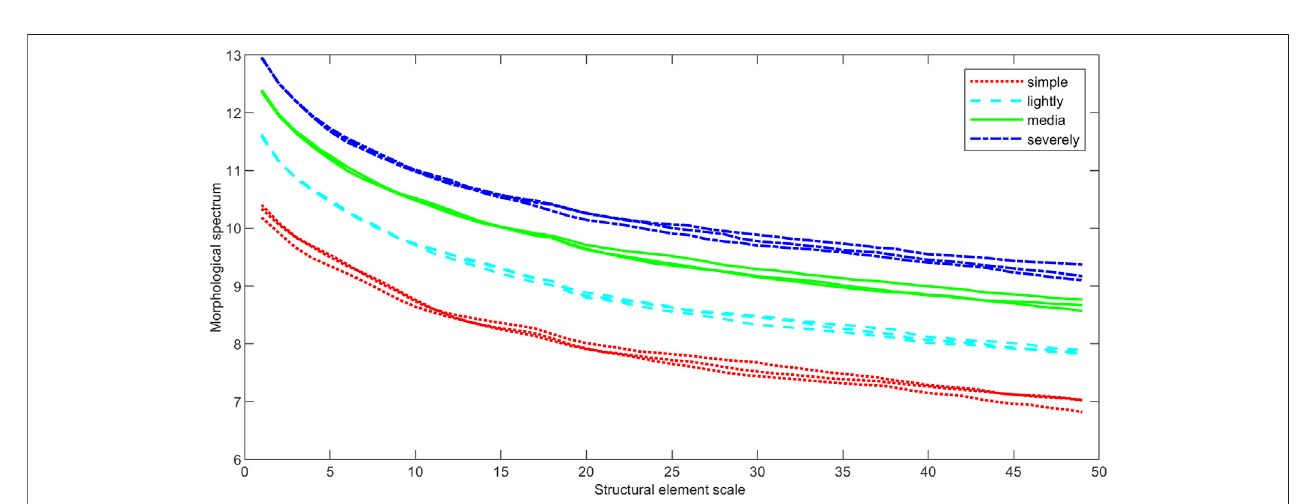
FIGURE 8 | LMGS analysis result of line